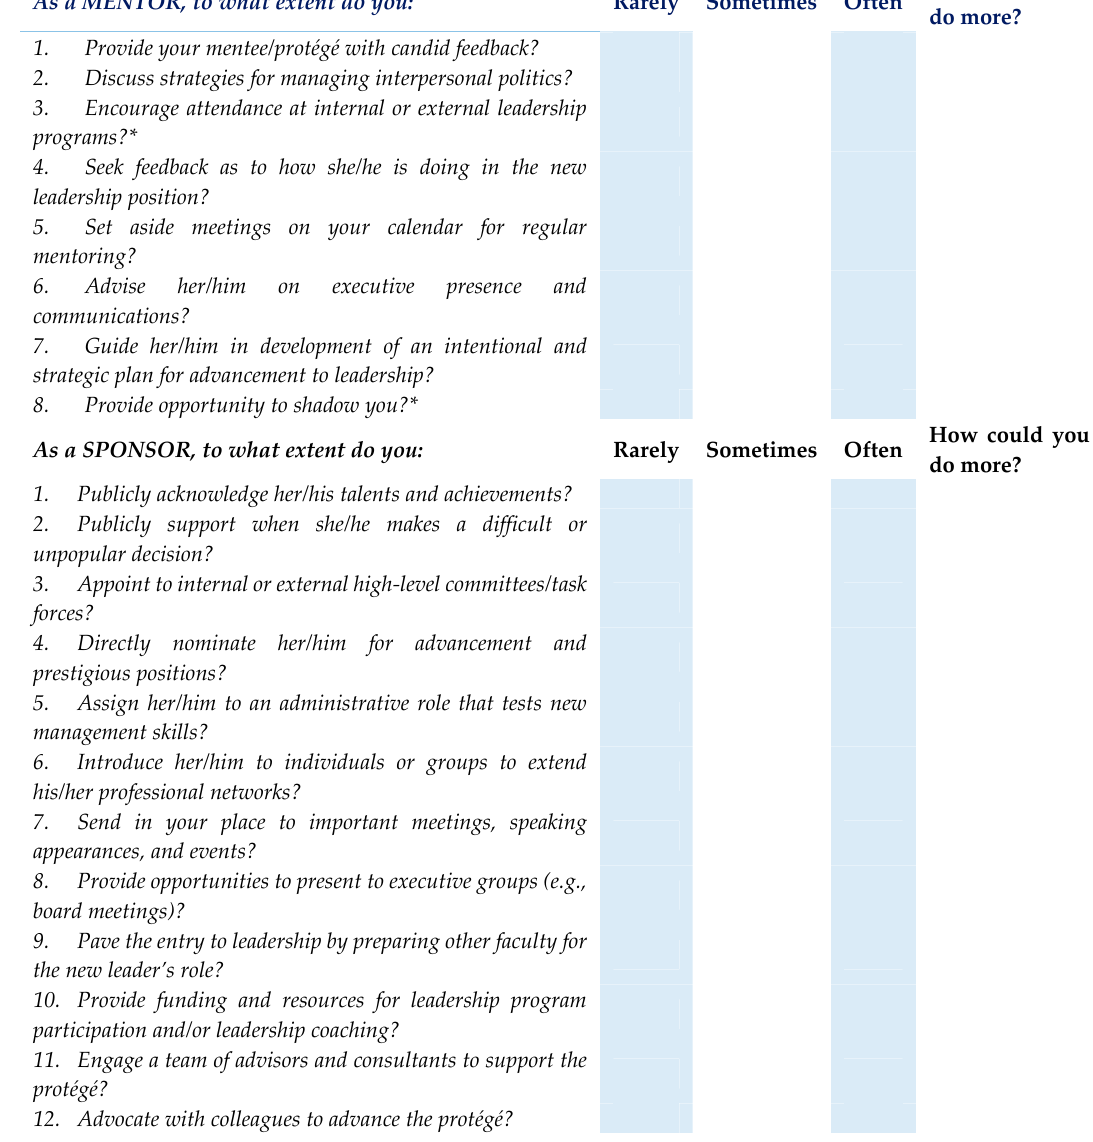
Figure 1. Leadership Mentoring and Sponsoring Self-Assessment. * Note that some “mentoring” practices can be “sponsorship” if they are public and funded.